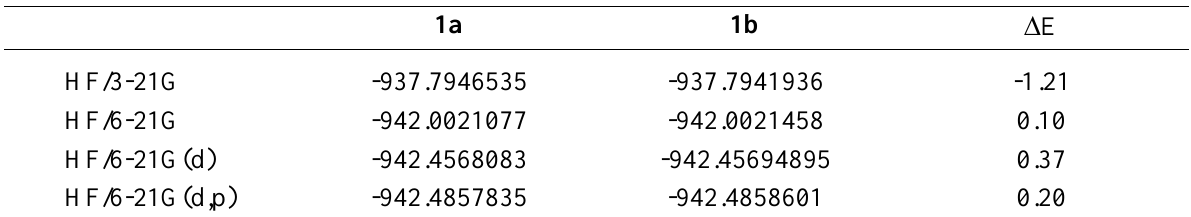
Table 2. Total energy for the two model structures of compound 1 (data in Hartrees, 1 Hartree